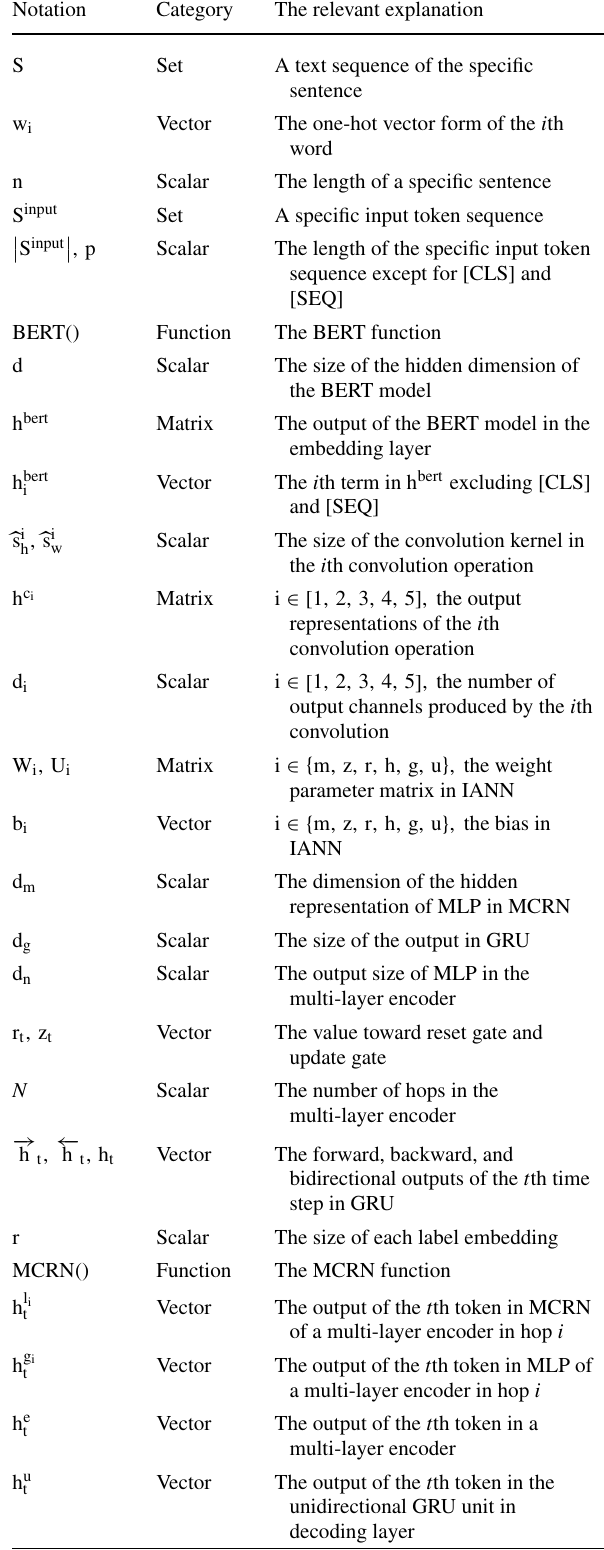
Table 1 The notations used in the proposed